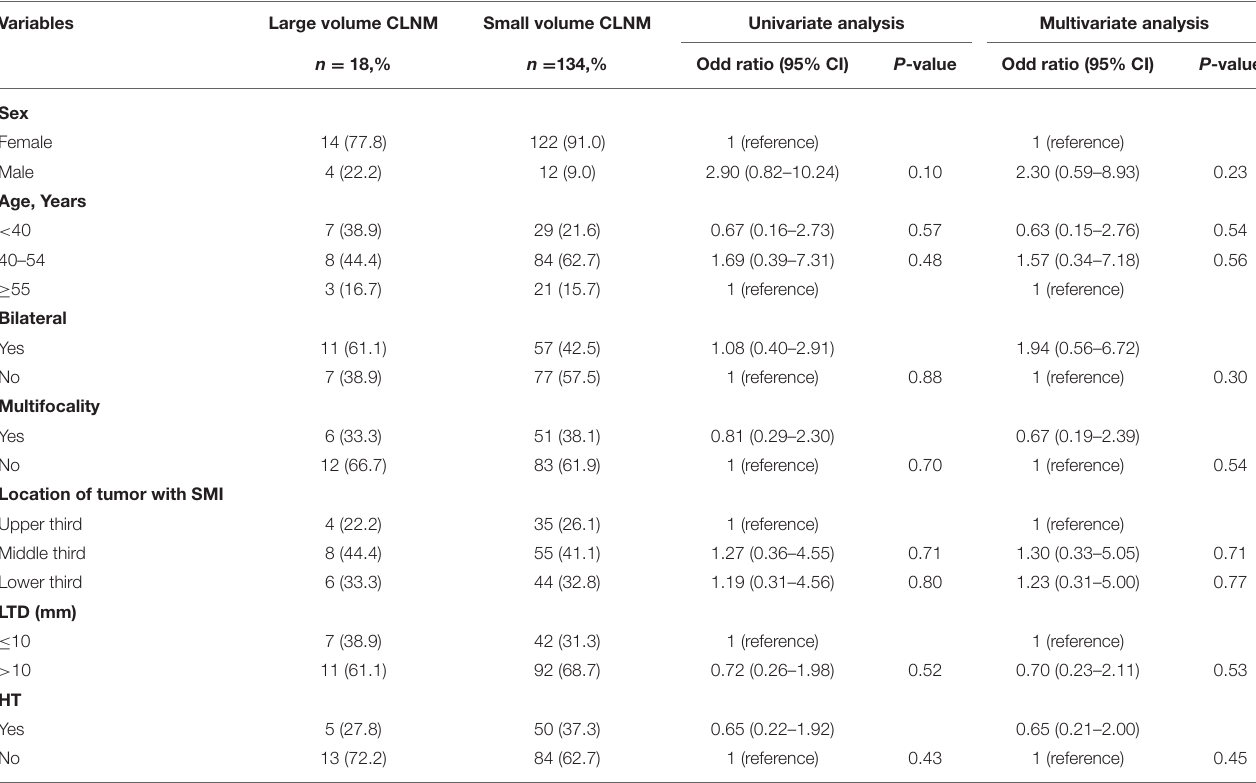
TABLE 3 | Univariate and multivariate analysis of clinicopathological characteristics for large volume CLNM in cN0 PTCs with SMI. Variables Univariate